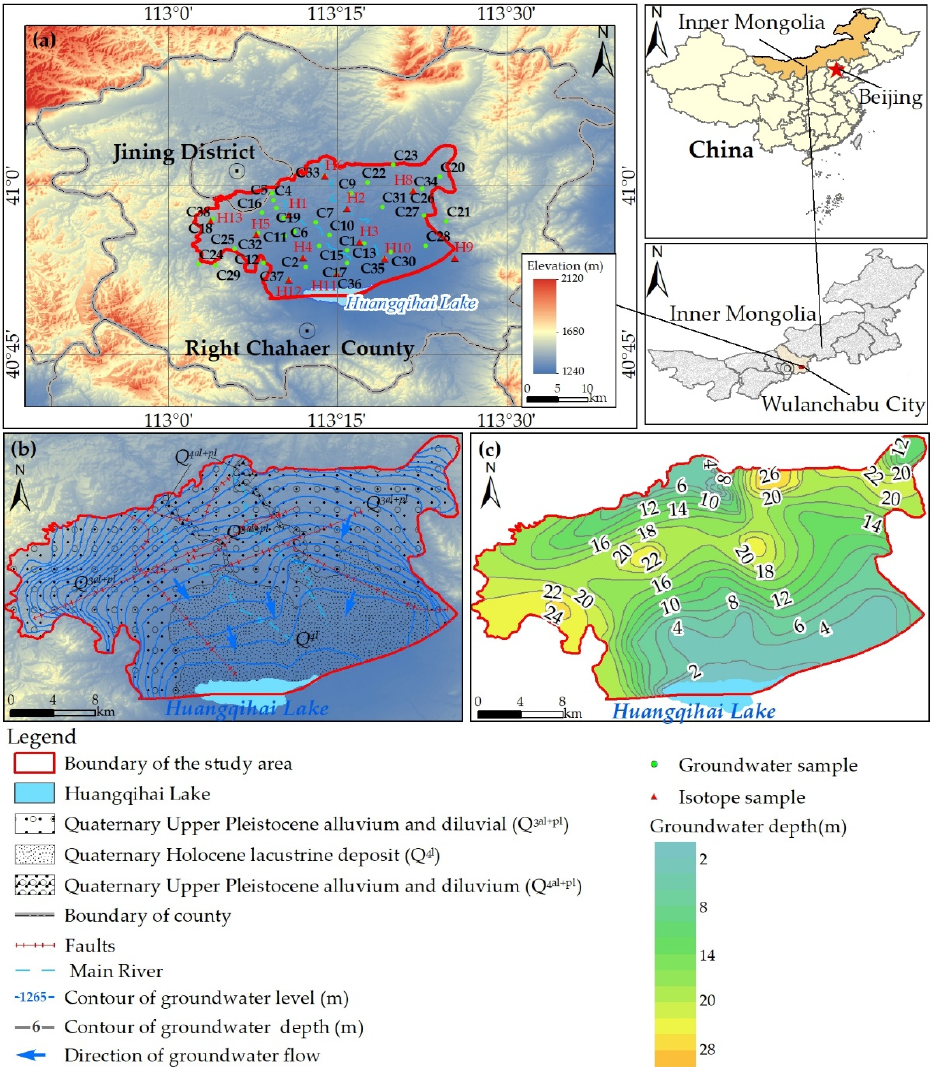
Figure 1. Location of the study area and water samples ( a ), hydraulic head field ( b ) and the burial depth of groundwater ( c ).